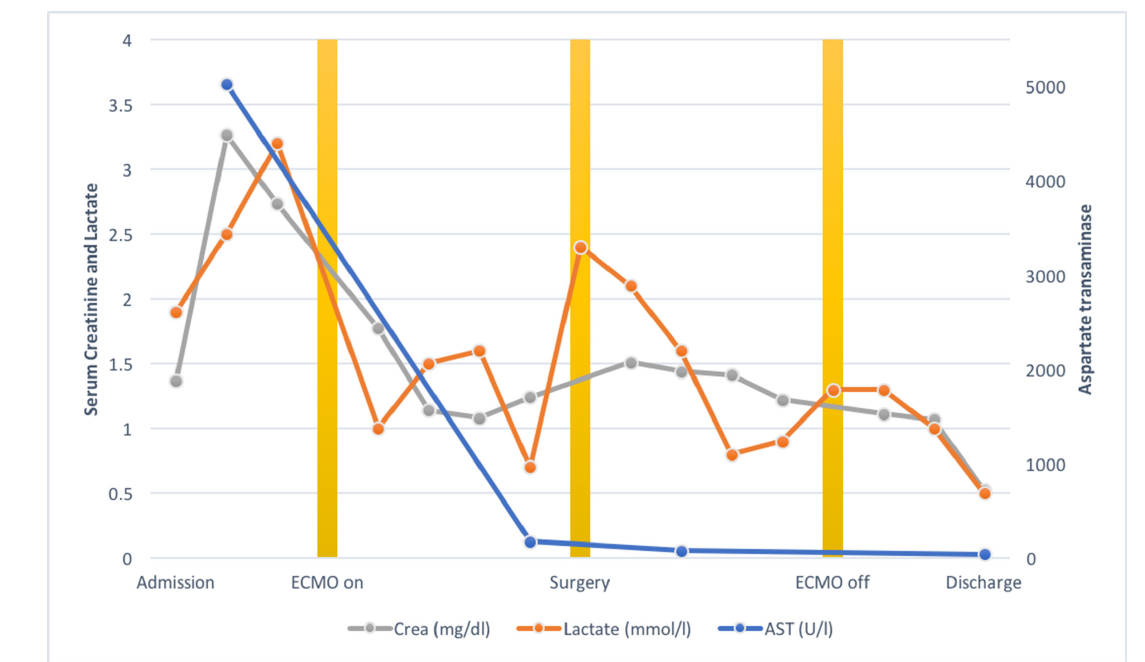
Fig. 2 - Laboratory parameters during hospitalization. Evolution of serum creatinine, lactate and aspartate transaminase levels is shown before, during, and after ECMO support. ECMO connection led to an improvement in all parameters.